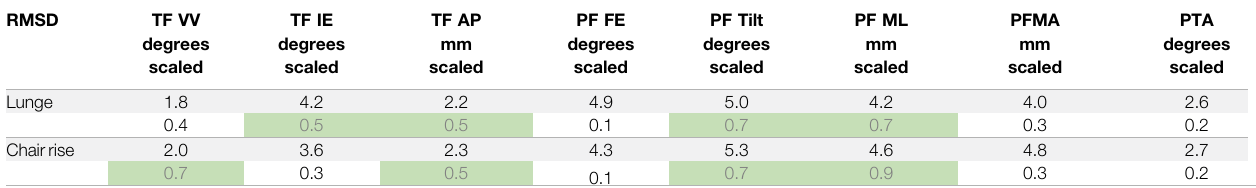
TABLE 2 | Root-mean-square difference (RMSD) between the non-weight-bearing and weight-bearing activities averaged across all subjects. Scaled RMSDs were calculated as the RMSD divided by the ROM in each degree of freedom. Green highlights scaled RMSD values of 0.5 or greater. RMSD TF VV